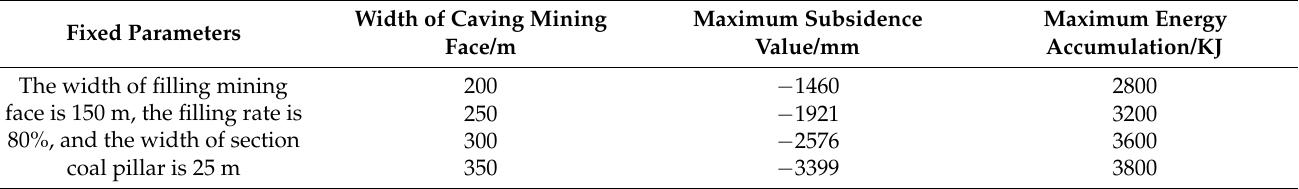
Table 11. Statistics of maximum surface subsidence and maximum energy polling distribution under different caving face